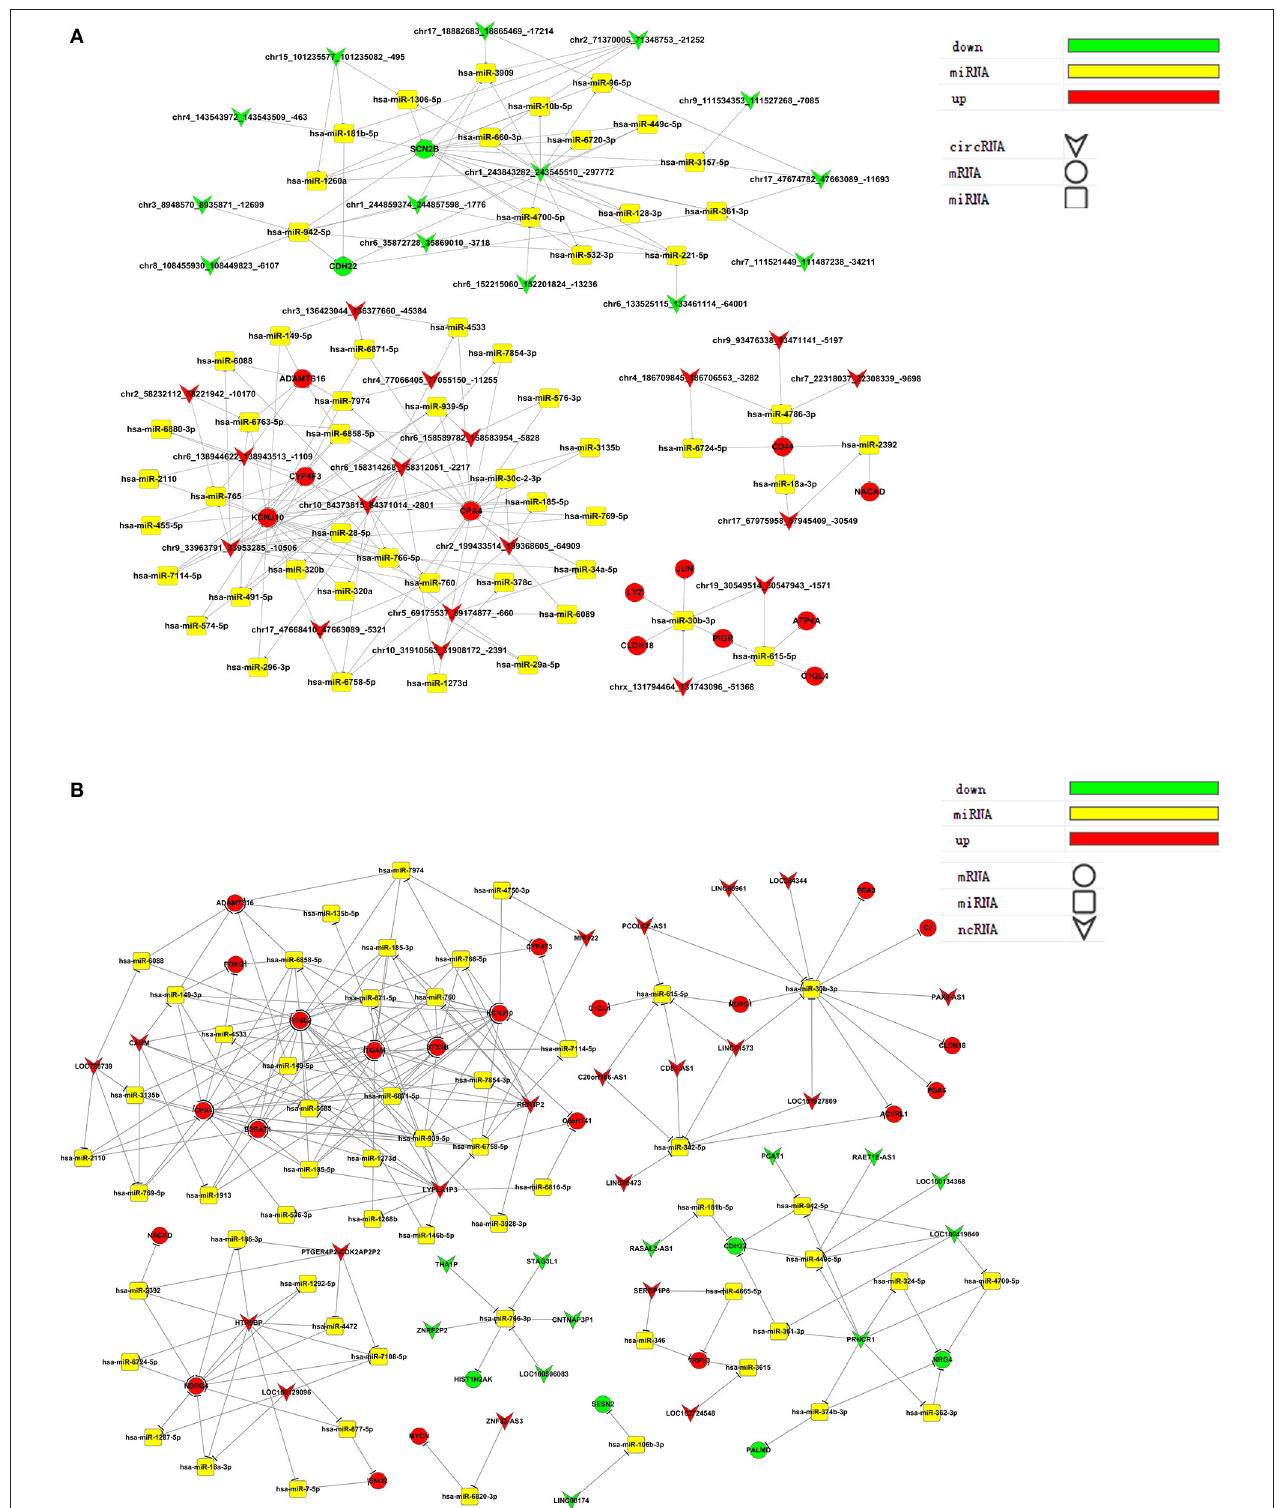
FIGURE 6 | ceRNA networks. (A) circRNA-miRNA-mRNA and (B) lncRNA-miRNA-mRNA ceRNA networks.